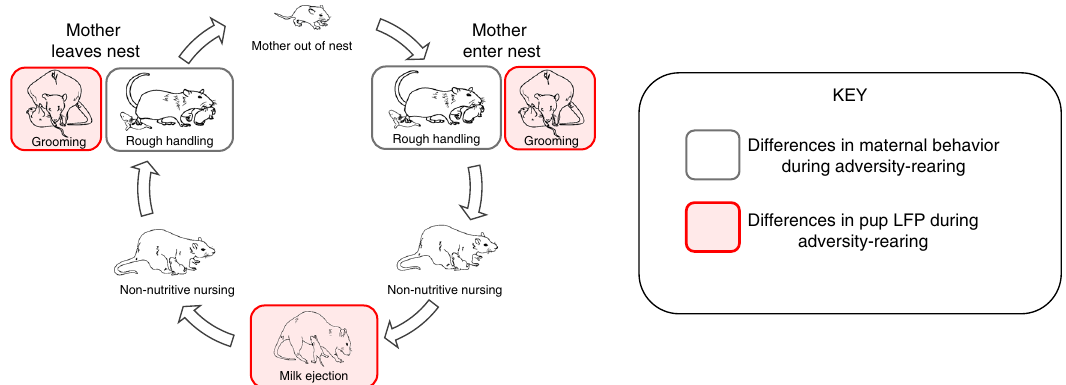
Fig. 7 Differences in maternal behavior during maltreatment do not align with altered pup cortical processing of maternal behavior. The typical sequence of maternal behavior does not change between control and adversity-rearing: pups are left alone in the nest as the mother attends to her biological needs. Upon returning to the nest, the mother adjusts bedding, moves, and grooms pups as she begins to nurse. During most of nursing, pups are non-nutritively nursing, which is interrupted periodically by a milk ejection, which produces a robust stretch re fl ex in pups. Although low bedding induces increased rough handling by mothers (gray border) upon entering/exiting nest, speci fi c maternal nurturing behaviors (red) were associated with the most robust differences in pups ’ cortical reactivity between the control and low bedding groups. Please see Supplementary Materials for expanded discussion of mother – pup interaction within